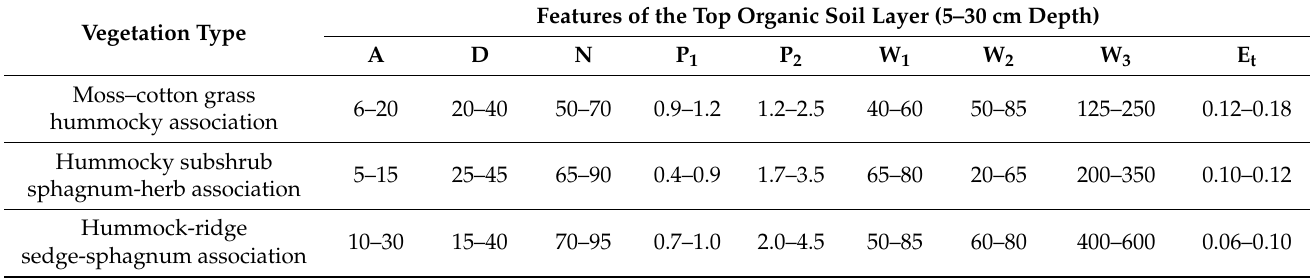
Table 1. Some hydrophysical properties of peaty and peat soils in the Anadyr Lowland landscapes. Features of the Top Organic Soil Layer (5–30 cm